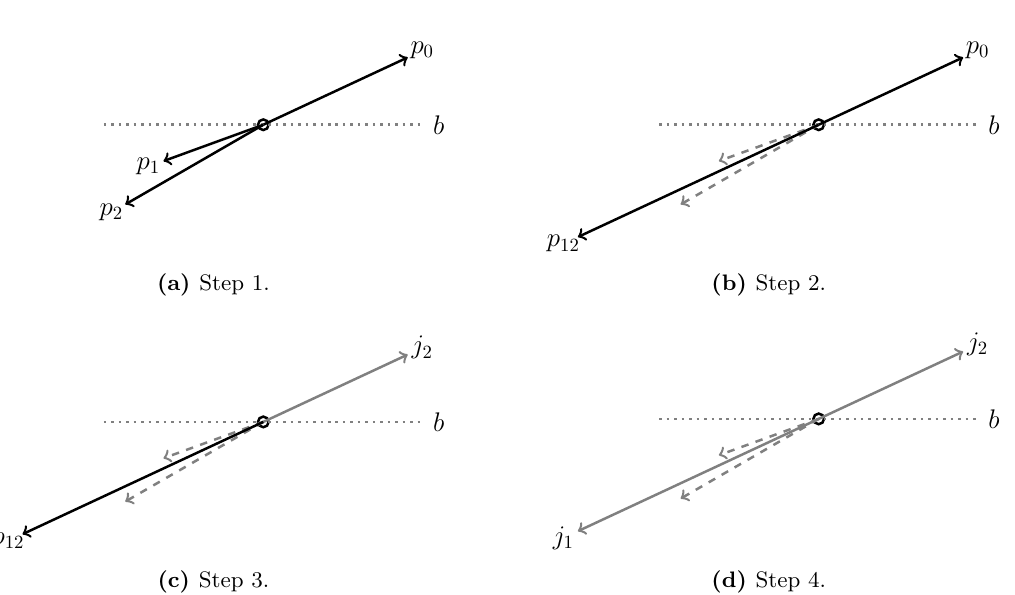
Figure 1. Simpli(cid:12)ed illustration of the k t clustering algorithm, starting with three input momenta p 0 , p 1 and p 2 (step 1). The dotted line labelled b represents the beam line. In step 2, the minimum distance measure is the one between two input momenta p 1 and p 2 , so that the two input momenta are replaced by their vector combination. In step 3, the minimum distance measure is between the p 0 and the beam line, so that p 0 is declared a jet ( j 2 ) and removed from the input list. Finally in step 4, there is only the combined input momentum p 12 left and so it will be declared a jet ( j 1 ) and the algorithm